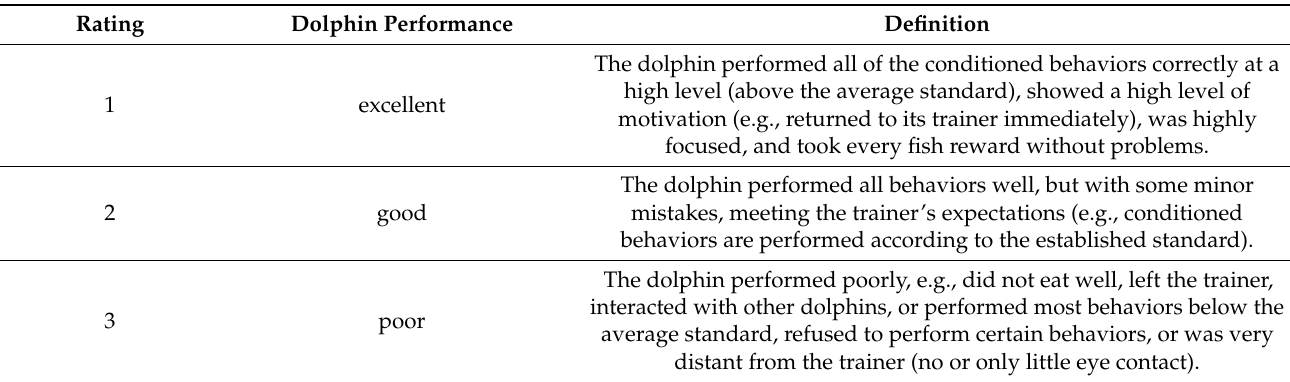
Table 4. The three-point rating scale used by the trainers to evaluate each dolphin’s performance after each training session.